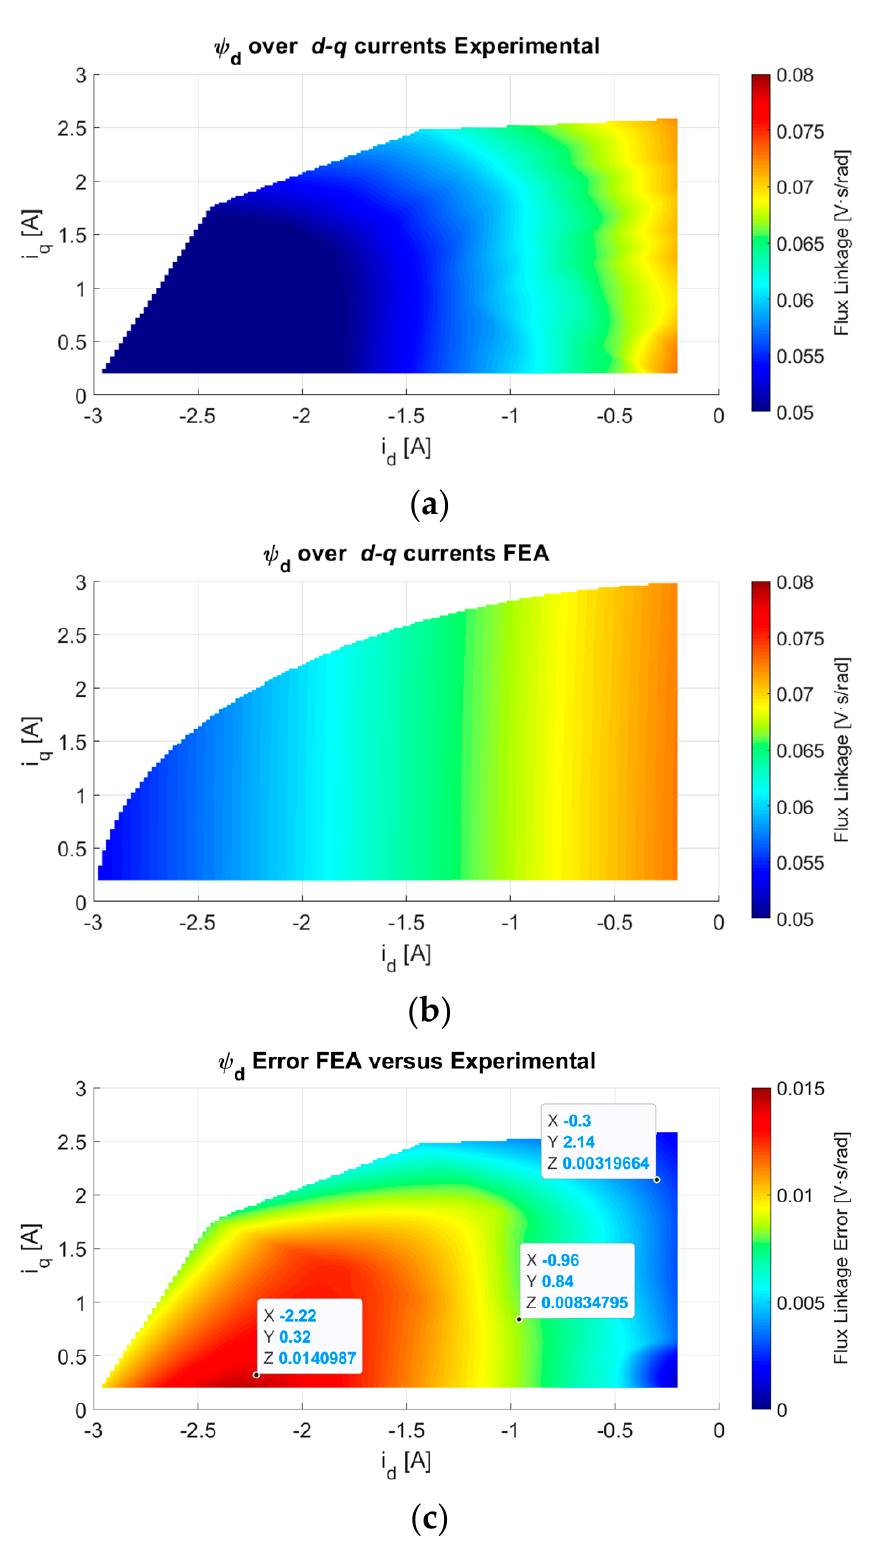
Figure 5. Direct Flux linkage map versus the d-q currents. ( a ) Parameter estimation values extracted from experimental data. ( b ) FEA values. ( c ) Absolute error between FEA and experimental maps.